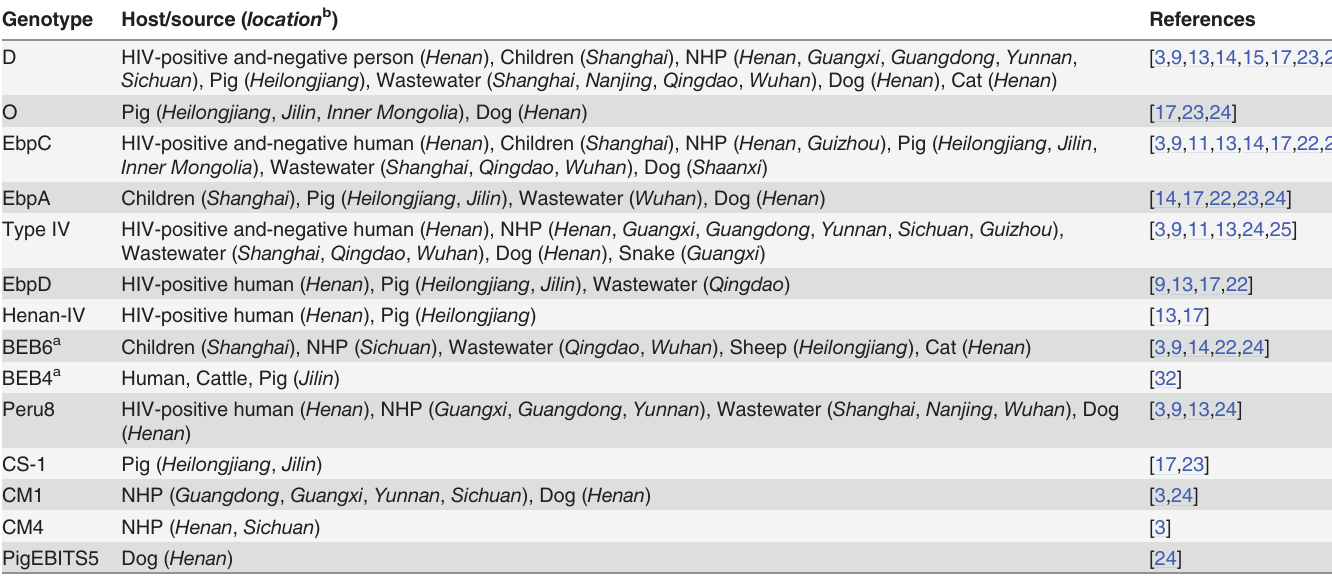
Table 3. Summary on the distribution of known E . bieneusi genotypes of this study in China. Genotype Host/source ( location b